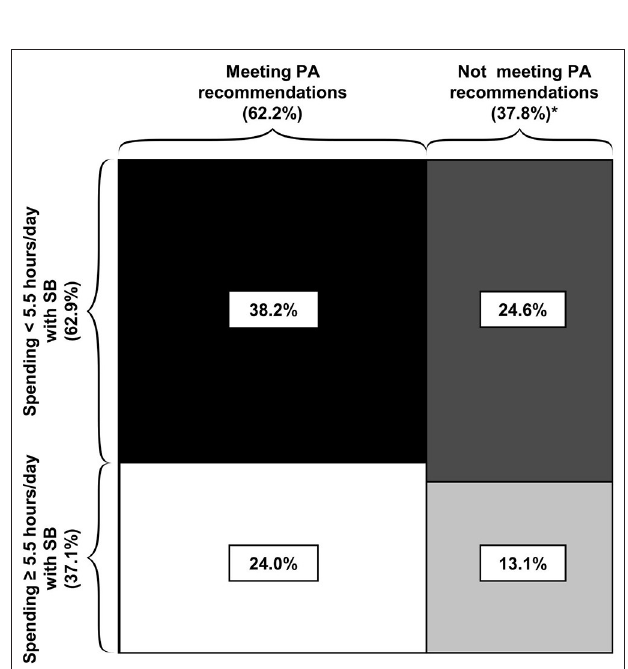
FIGURE 2 | Prevalence within the four groups of combined physical activity and sedentary behavior patterns. *Differences in the sum are due to rounding. Areas reflect the number of participants in corresponding